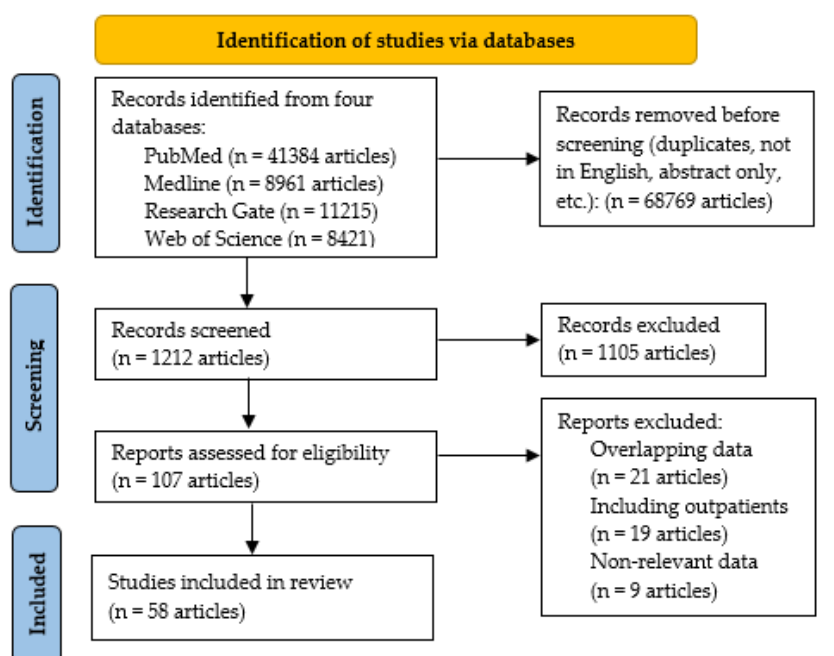
Figure 2. PRISMA flowchart of the medical articles selection .